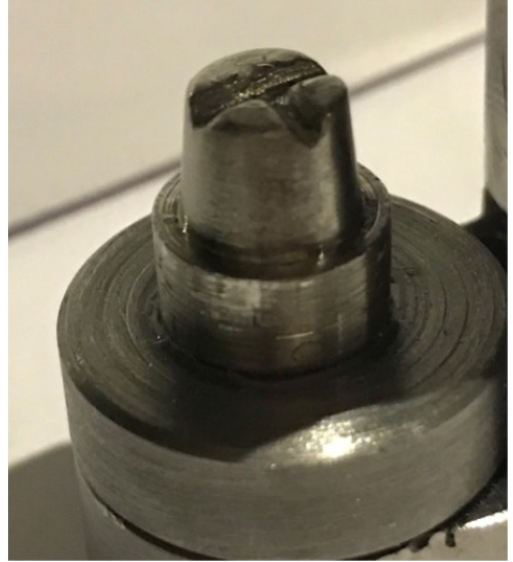
Figure 1. Master model.